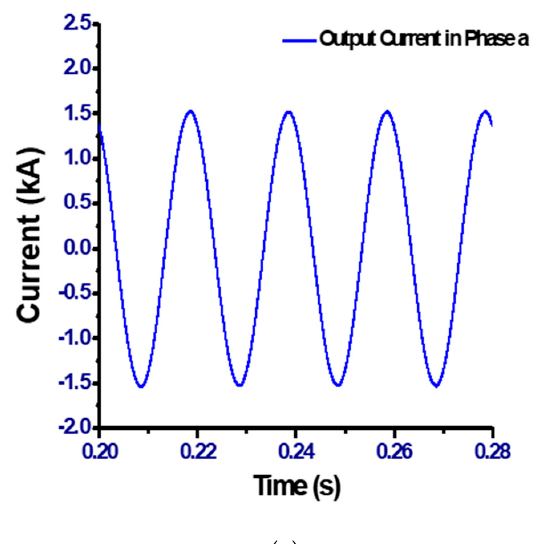
Figure 7. Results of( a ) reference signal-direct modulation;( b ) reference signal-proposed direct